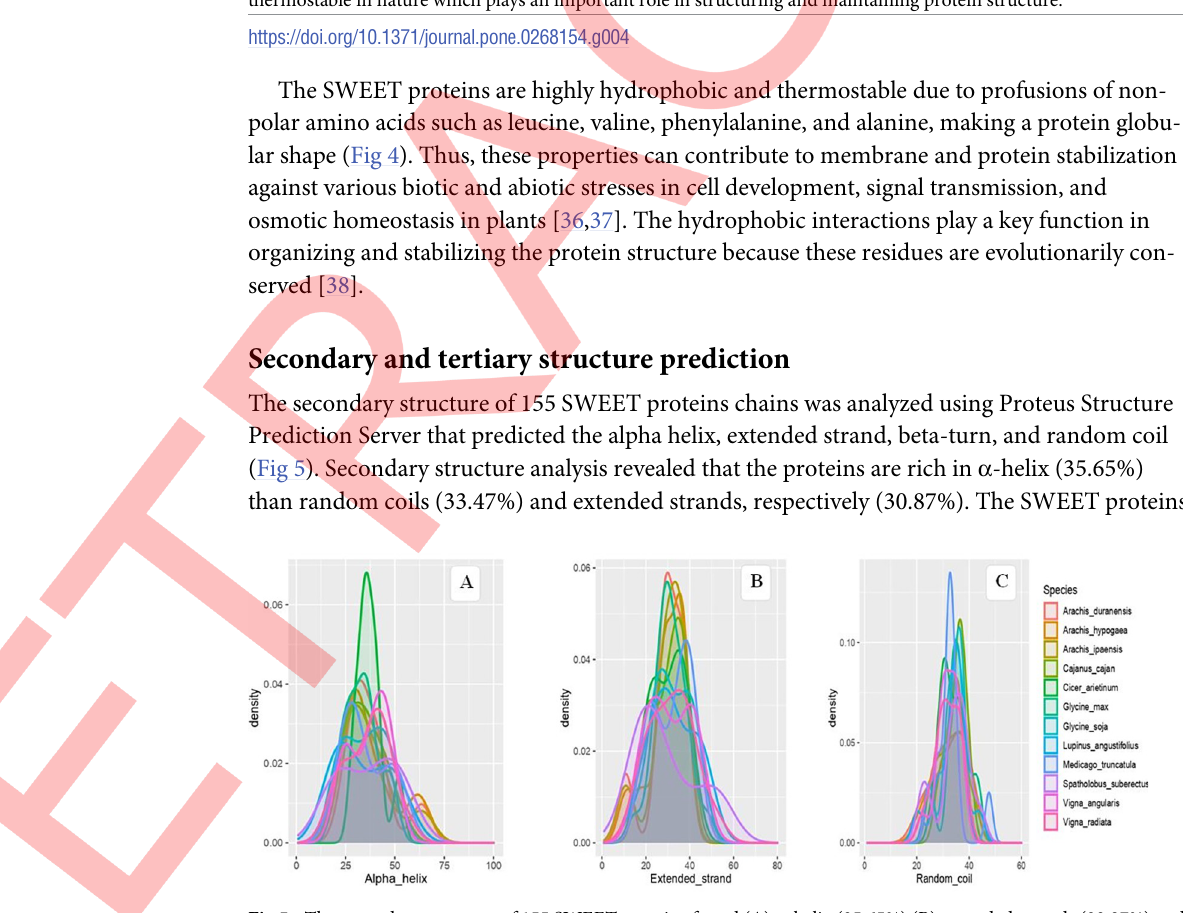
Fig 5. The secondary structure of 155 SWEET proteins found (A) α -helix (35.65%) (B) extended strands (30.87%) and (C) random coils (33.47). This suggests that SWEET proteins are composed more of alpha helix chains and random coils than extended strands. The graph shows percentage of sequence on X-axis and density on